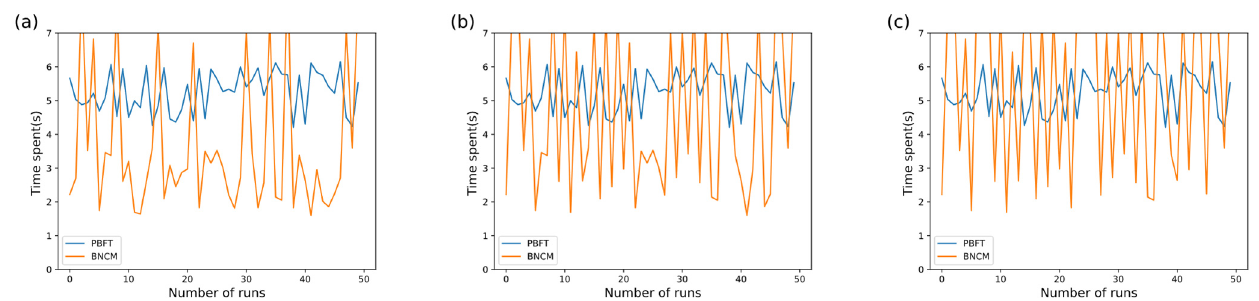
Figure 14. Comparison of VPPTM and PBFT collaborative processes. ( a – c ) B DER has 20%, 40%, and 60% failure